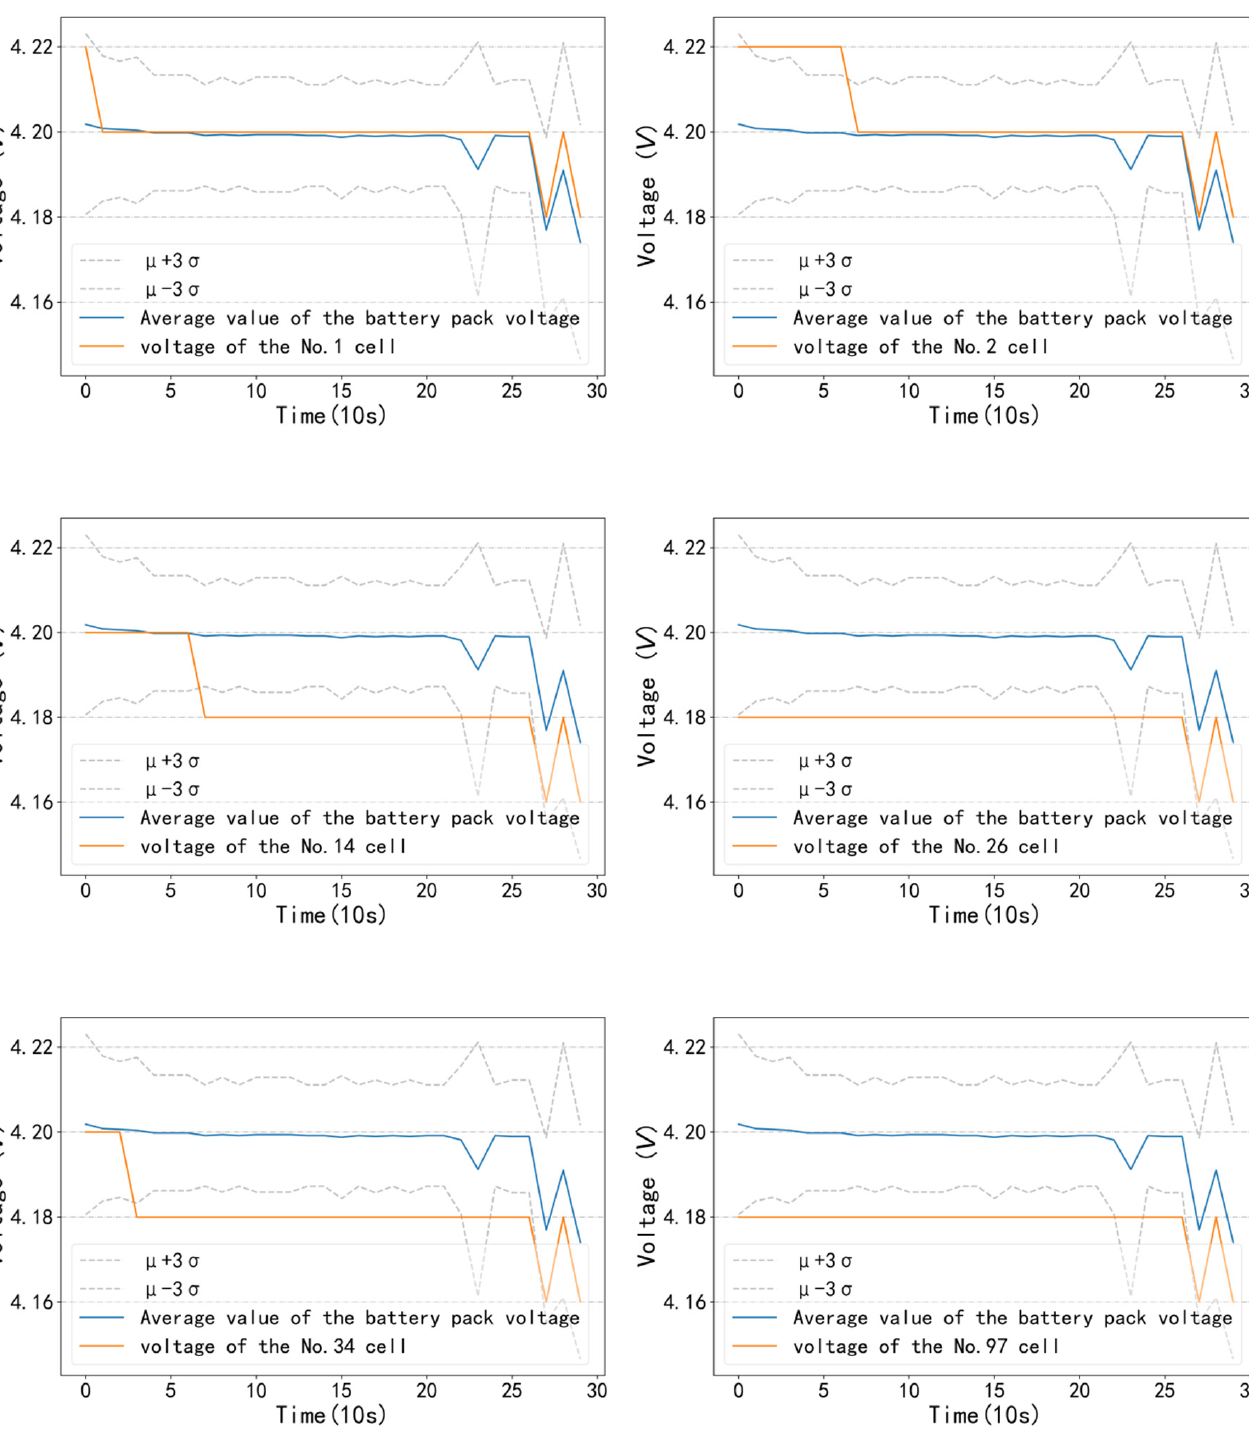
Figure 16. Graphs of the voltage of single batteries over time.